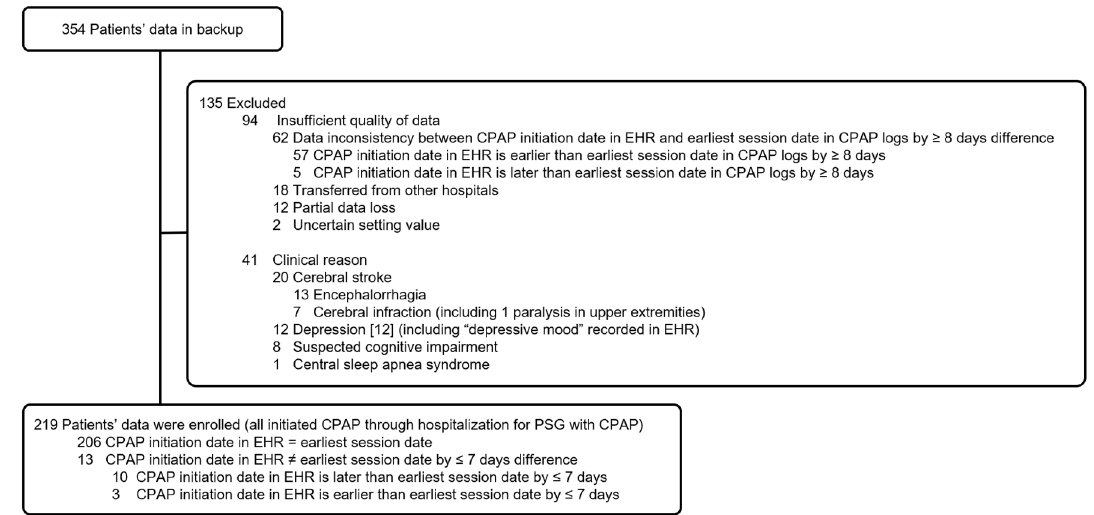
Figure 1. Flowchart of participant selection. Definition of abbreviations: CPAP = continuous positive airway pressure; EHR = electric health